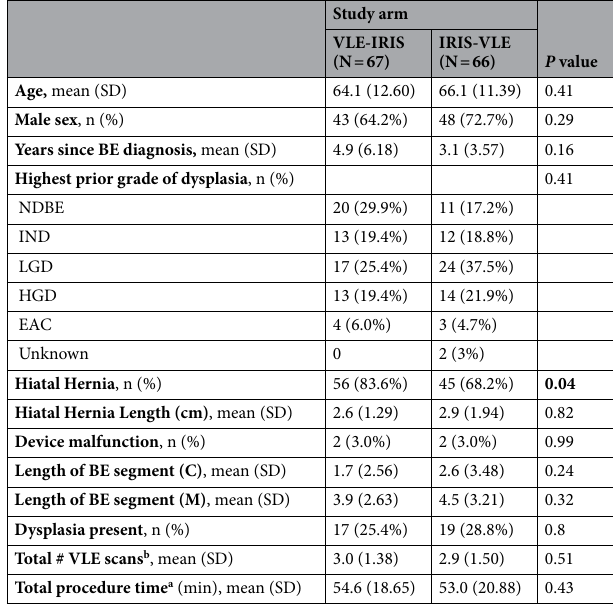
Table 1. Patient demographics and clinical characteristics. Significant values are in bold. SD standard deviation, NDBE non-dysplastic Barrett’s esophagus, IND Barrett’s esophagus indefinite for dysplasia,